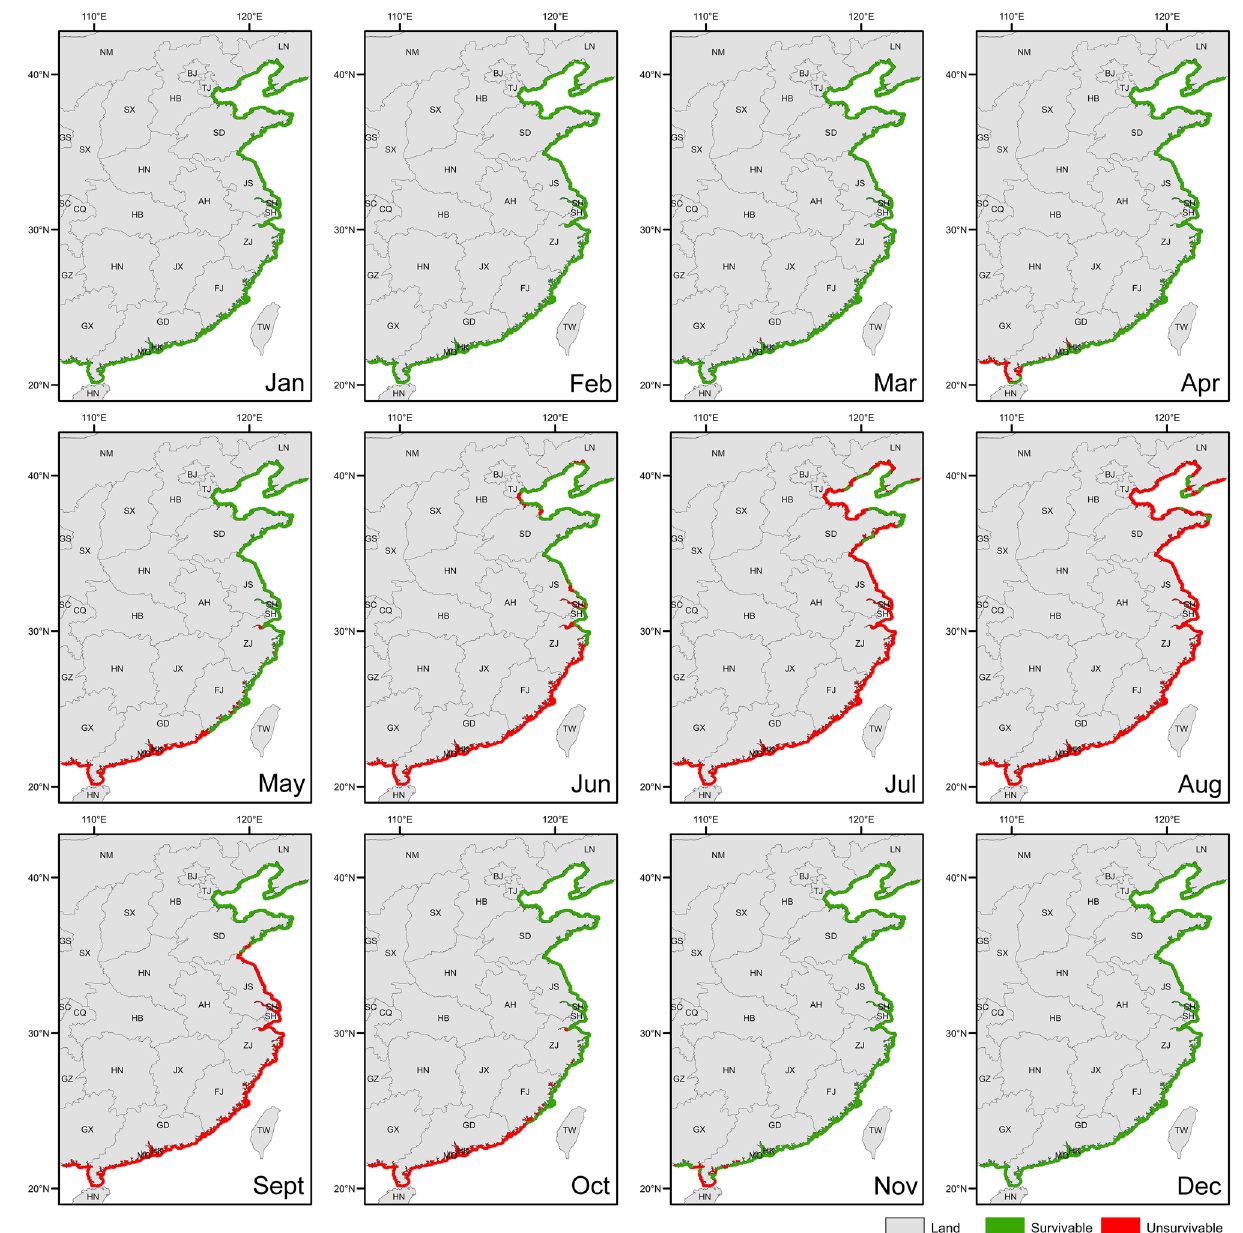
survive. The red indicates sea surface temperatures that exceed the tolerance of S. intermedius